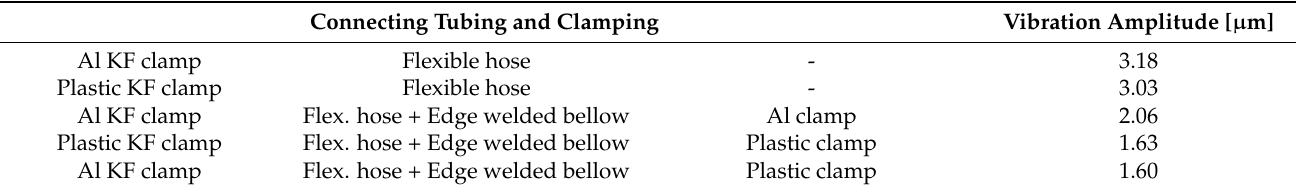
Table 1. Amplitude of oscillations at the turbo-pump with different damping components in between turbo-pump and fore-pump. Plastic clamps and edge-welded bellows reduce the transmission of the vibration to an acceptable level. The base amplitude of the fore-pump is 30 µ m. The electronic noise background is 0.1 µ m. Plastic connections reduce the vibration transmission and allow for a galvanic